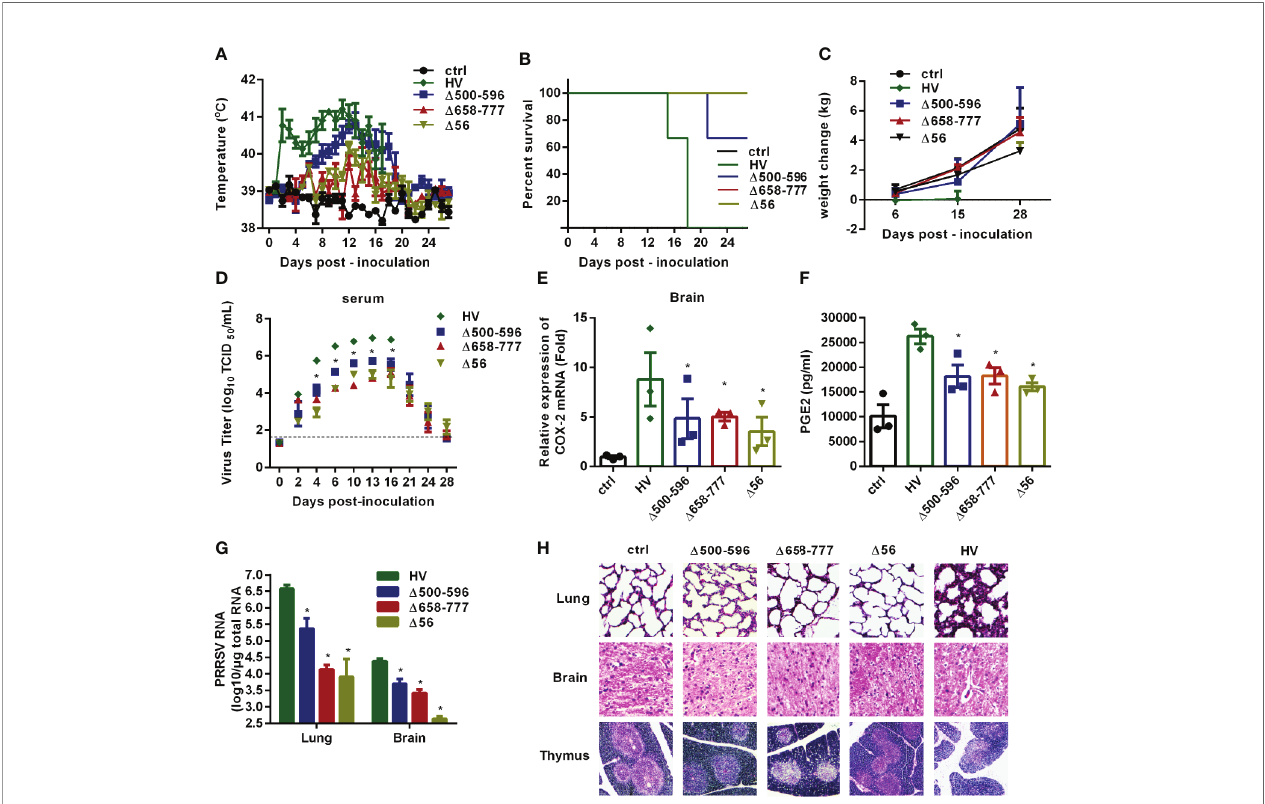
FIGURE 9 | The mutant viruses D 500-596, D 658-777, and D 56 are less virulent in vivo . Pigs were intranasally inoculated with HP-PRRSV strain HV, D 500-596, D 658-777, and D 56 at a dose of 2 mL × 10 5 TCID 50 virus/mL, respectively. (A) Rectal temperature of piglets was measured every day post-infection, and shown as the means ± SEM, except the number of survival piglets in each group was less than two. (B) Survival curves of piglets in each group. (C) Weight changes of piglets in each group. (D) Virus titers in serum of piglets inoculated with the HV or mutant viruses were determined by real-time PCR, and known amounts of serially diluted in vitro transcript virus cDNA were used to generate a standard curve for each plate run. The limit of serum virus titers detection was indicated in dashed line. (E – H) Three of each group piglets were euthanized at 6 days post-inoculation, and tissues and cerebrospinal fl uid of piglets were collected; COX-2 expression in brain was analyzed by real-time PCR (E) , and PGE2 production in cerebrospinal fl uid of piglets was measured by ELISA (F) ; virus RNA loads in tissues (lung and brain) were detected by real-time PCR (G) ; tissues were fi xed in 10% neutral-buffered formalin and routinely processed for histological examination, lung 10 × 10, brain 10 × 10, thymus 4 × 10 (H) . Statistical analysis was performed by Student ’ s t -test. *, P < 0.05